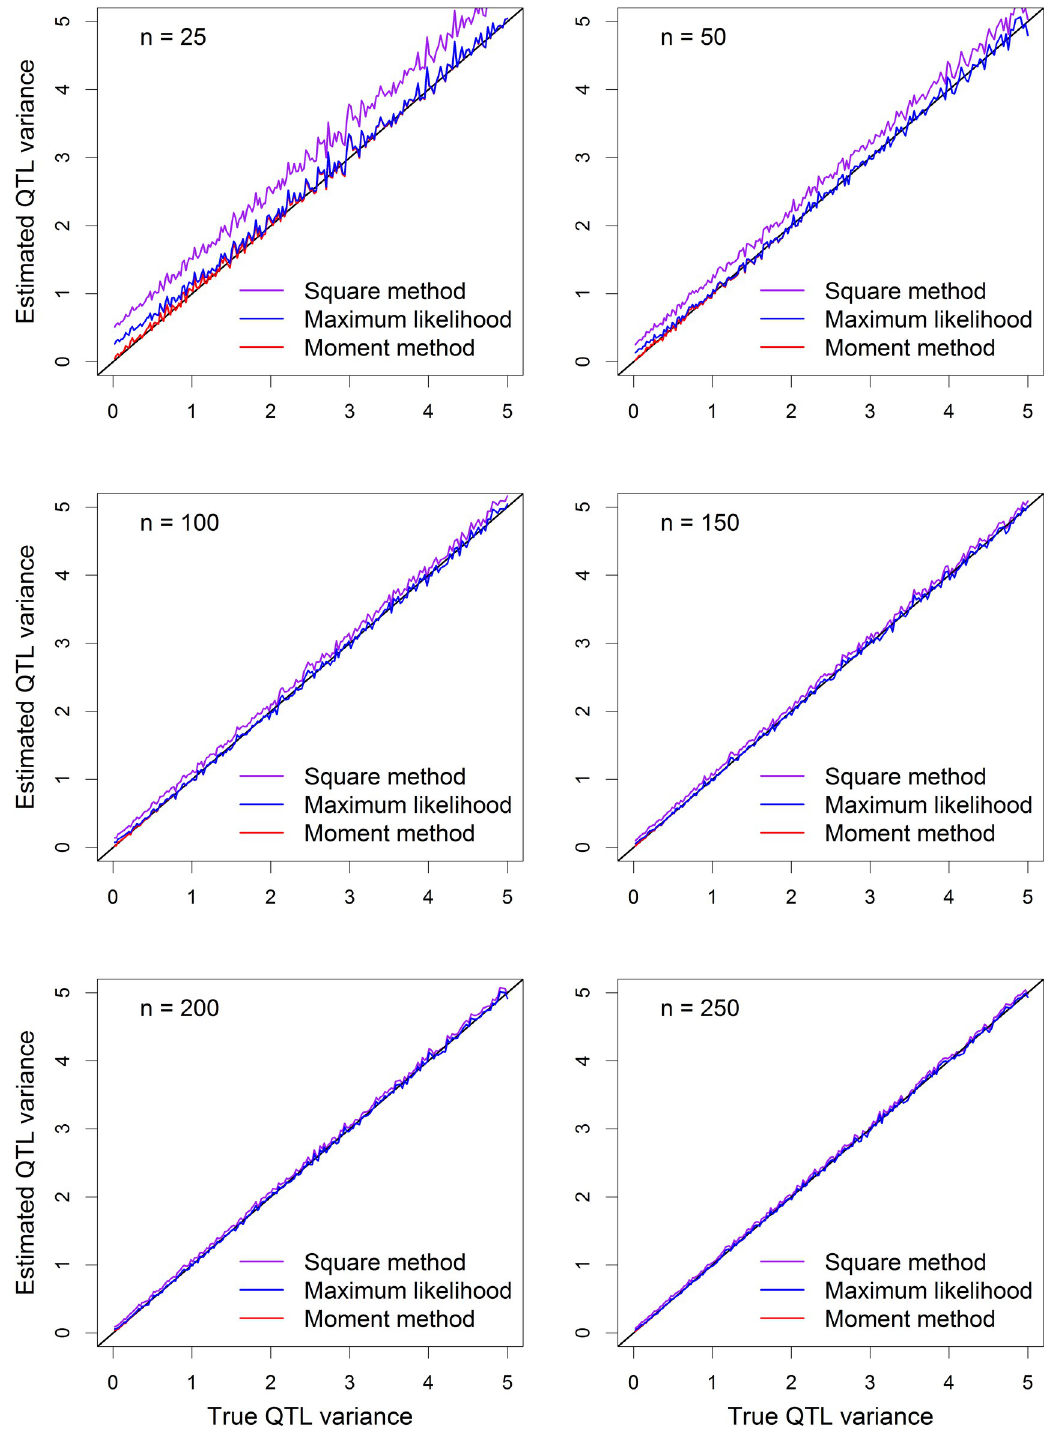
Fig 4. Plots of estimated QTL variance against the true QTL variance under the polygenic model. The six panels of the figure show the results of six sample sizes ( n ), which are 25, 50, 100, 150, 200 and 250, respectively.